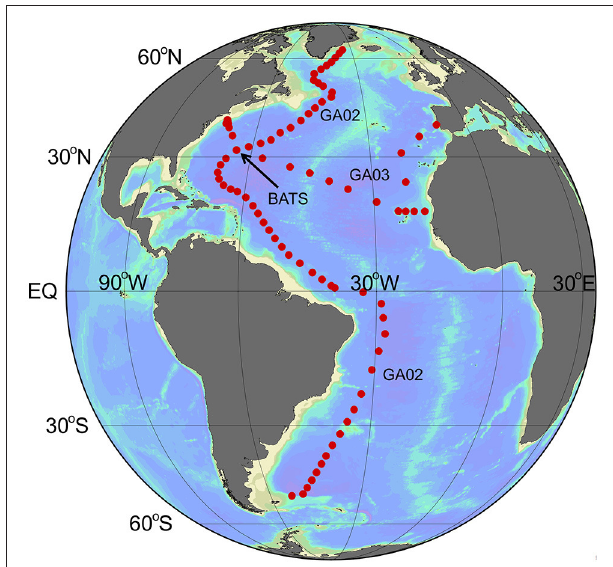
FIGURE 1 | Map of stations sampled as part of GEOTRACES cruises GA02 and GA03. The Bermuda Atlantic Time-series Study (BATS) site, which serves as GEOTRACES Crossover Station A, is highlighted as the focus of this intercomparison